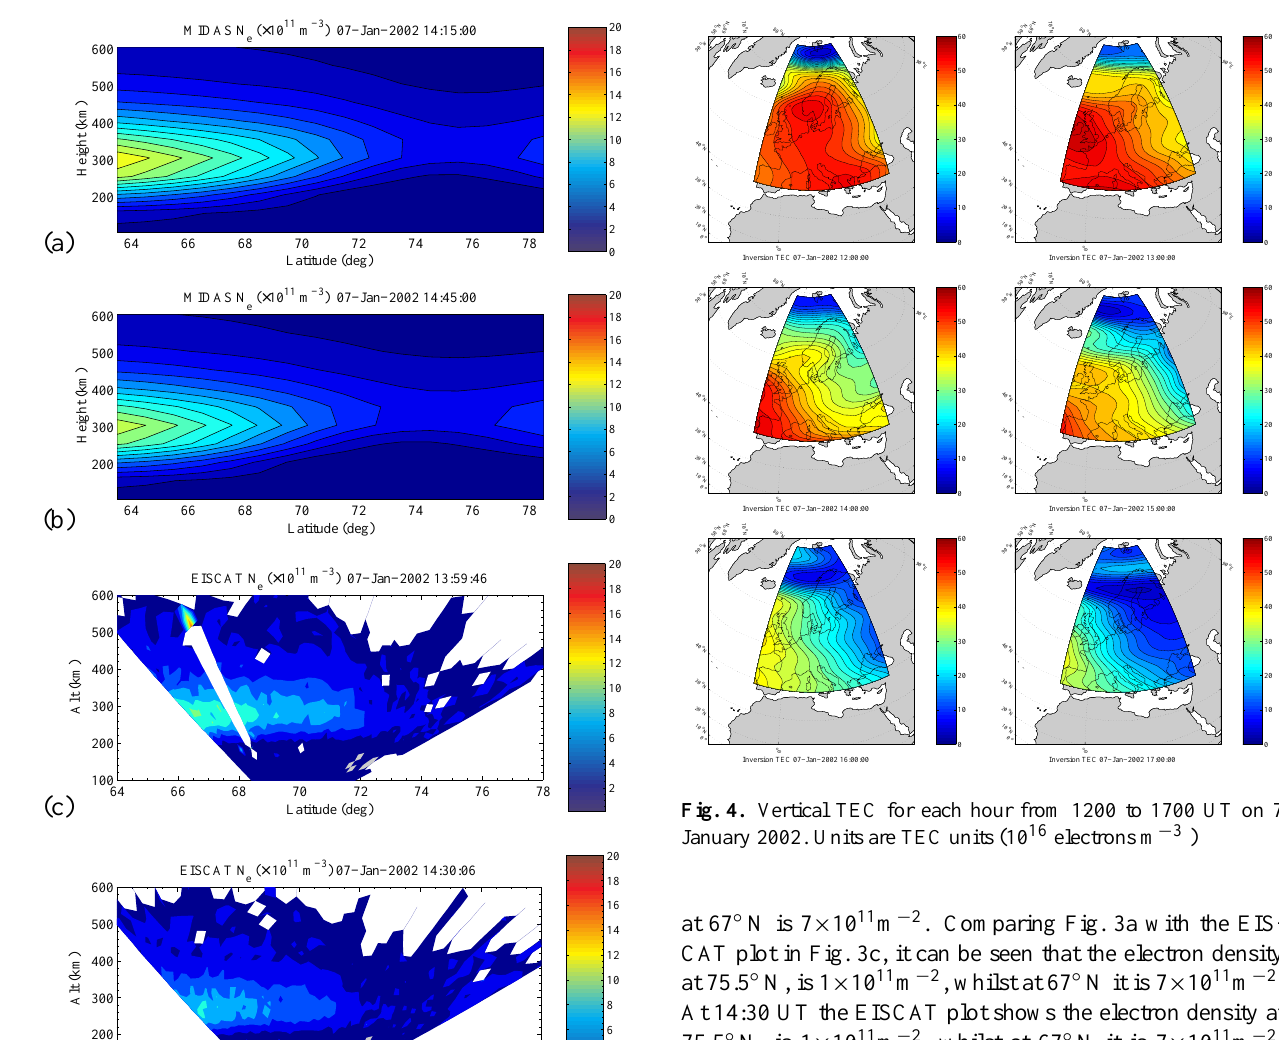
at 67 ◦ N is 7 × 10 11 m − 2 . Comparing Fig. 3a with the EIS- CAT plot in Fig. 3c, it can be seen that the electron density at 75.5 ◦ N, is 1 × 10 11 m − 2 , whilst at 67 ◦ N it is 7 × 10 11 m − 2 . At 14:30 UT the EISCAT plot shows the electron density at 75.5 ◦ N, is 1 × 10 11 m − 2 , whilst at 67 ◦ N it is 7 × 10 11 m − 2 . However, these comparisons should be treated with caution, since the EISCAT images each represent a half-hour period, and the temporal and spatial variability is significant over this